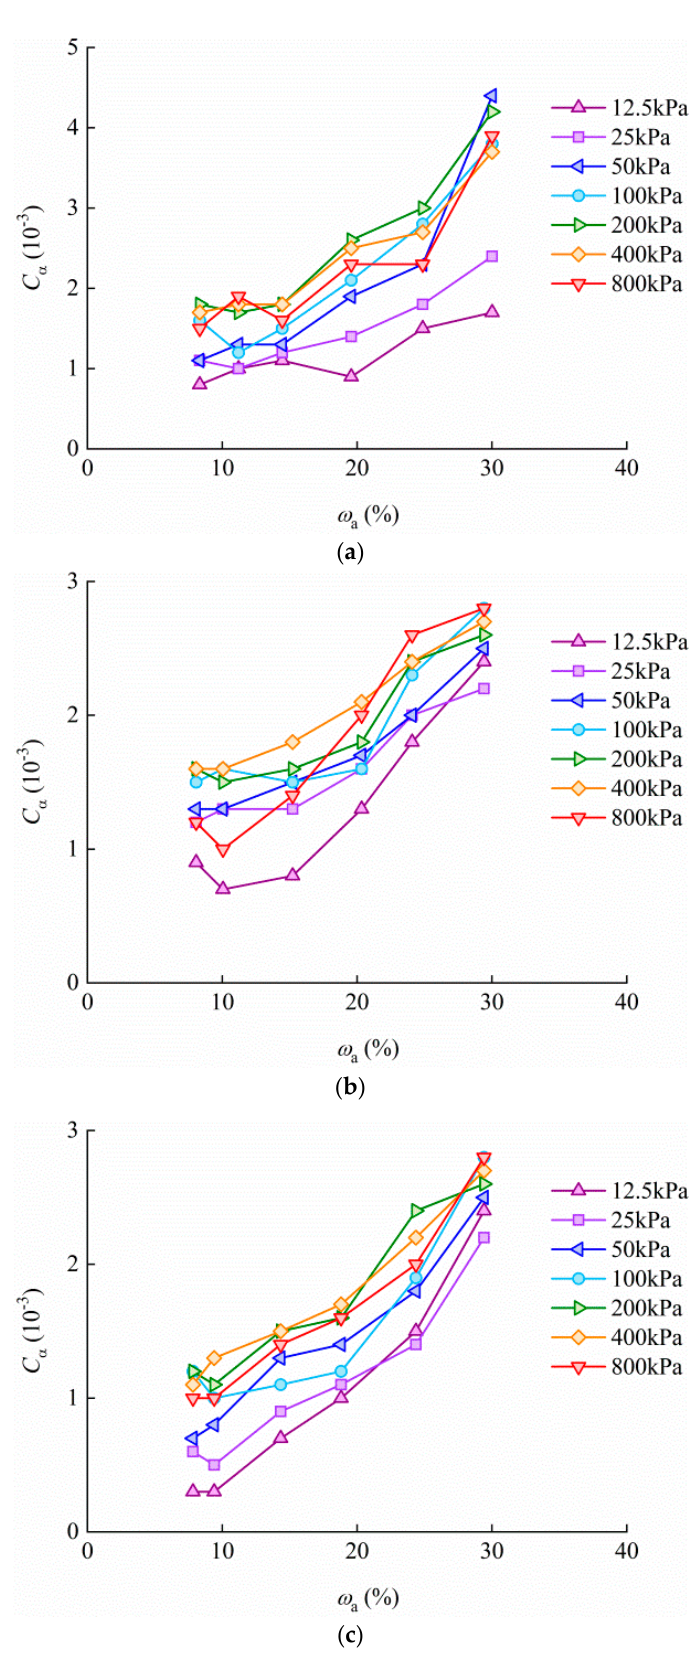
Figure 6. C α – ω a curves at different vertical stresses for ( a ) TJ, ( b ) QD, and ( c ) WH.